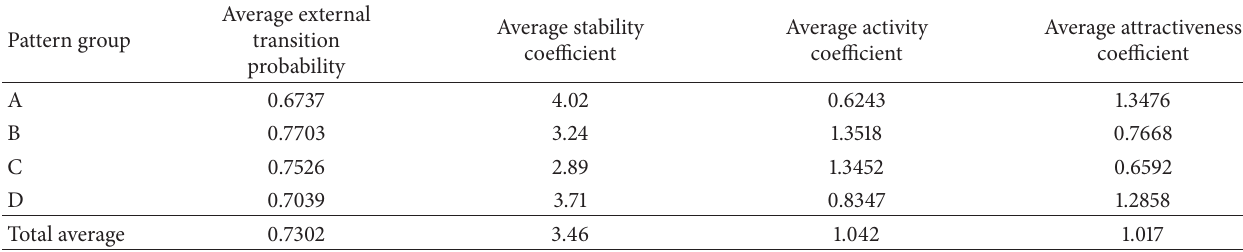
Table 2: Table of detailed characteristics of pattern group transition.